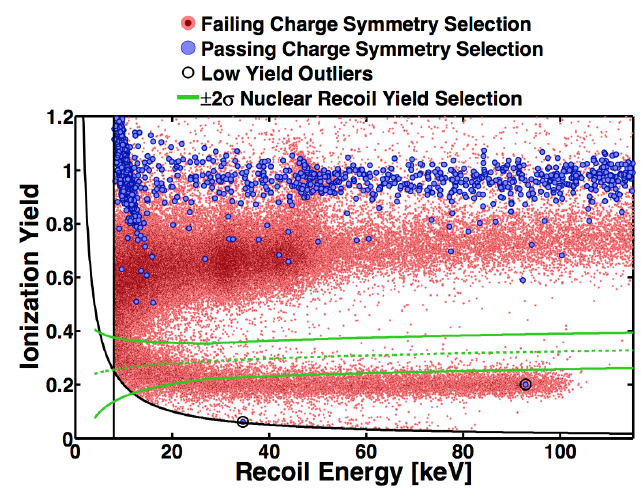
Figure 35: Ionization yield versus phonon recoil energy with the ± 2 σ ionization yield range of neutrons indicated (area within green lines). Taken from 900 live hours of calibration data from with a 2 10Pb source facing one side of a detector. The hyperbolic black line is the ionization threshold (2 keVee); the vertical black line is the recoil energy threshold (8 keVr). Symmetric charge events (large blue dots) in the interior of the crystal and the events that fail the symmetric charge cut (small red dots) include surface events from betas, gammas and lead nuclei and are clearly separated from the nuclear recoil band. Figure provided by the SuperCDMS Collaboration.